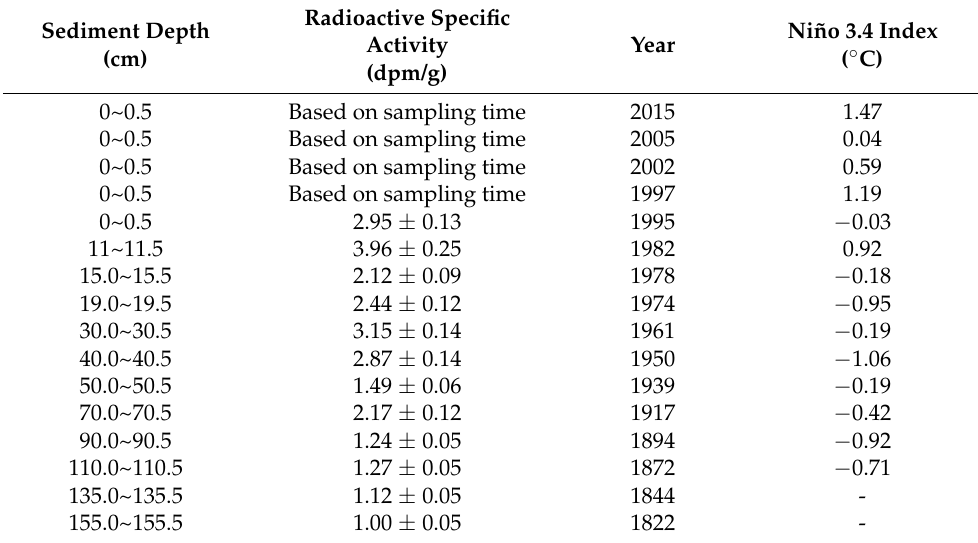
Table 3. Geological age of Sanmen Bay sedimentary column sample H30 measured by 210